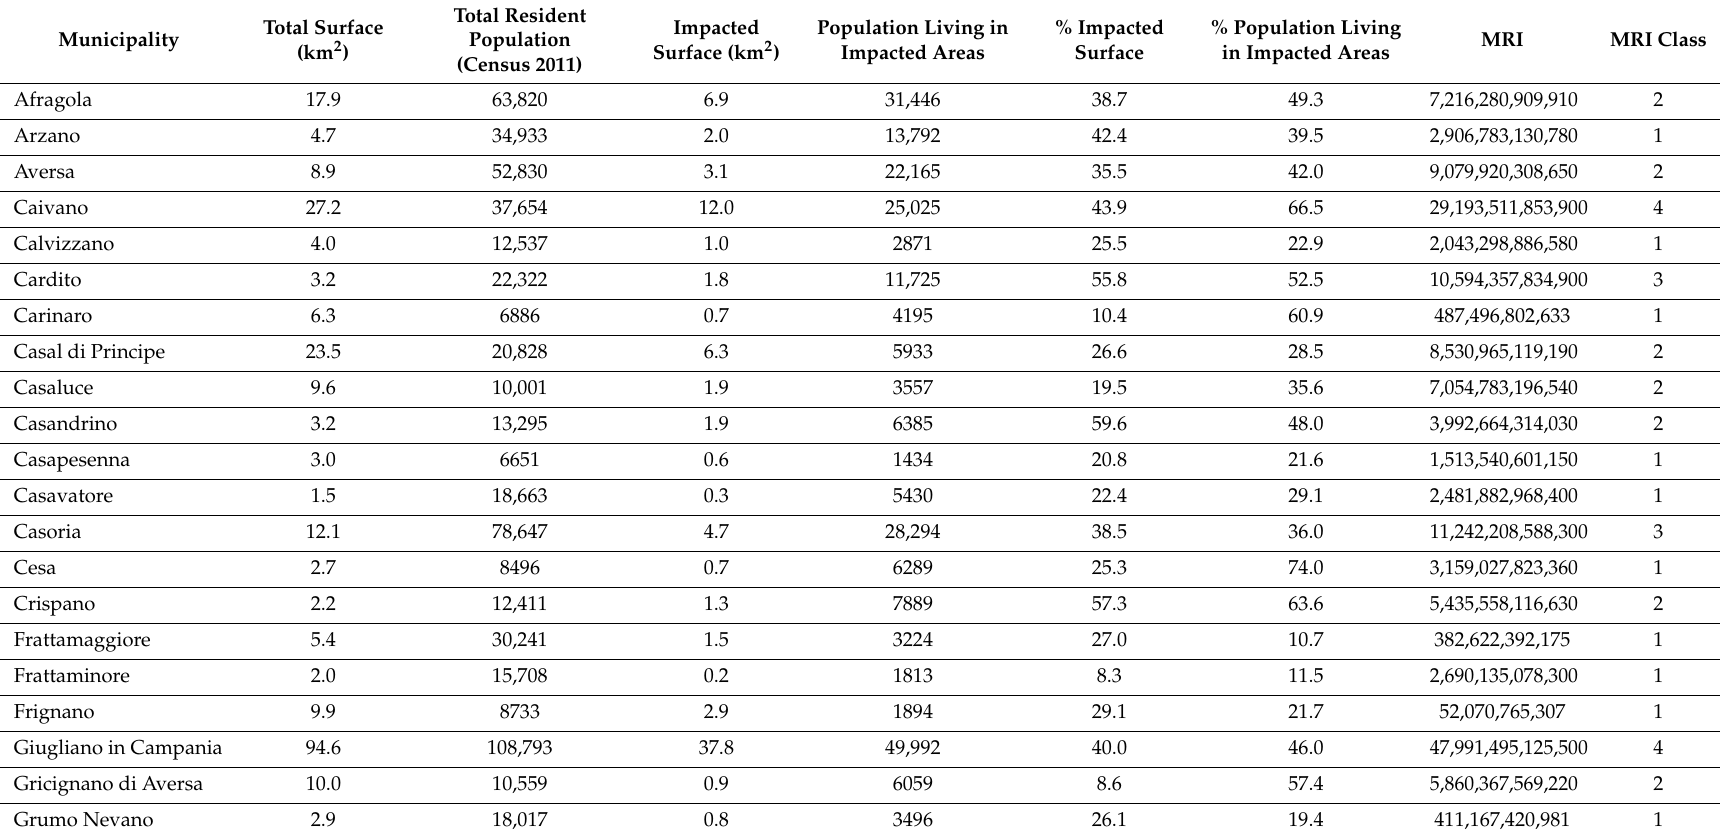
Table 4. Municipal Waste Risk Index (MRI) class, by